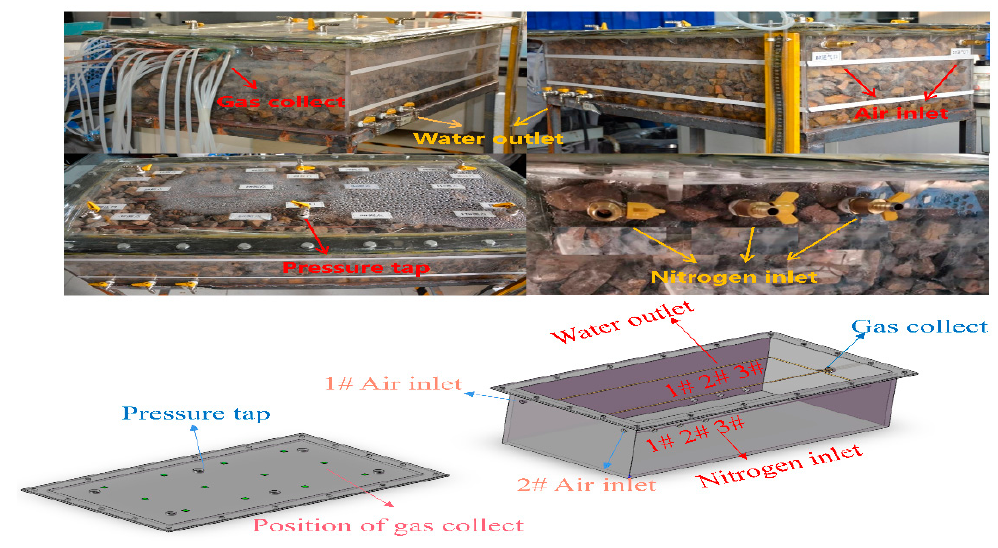
Figure 3. Test system for goaf drainage.